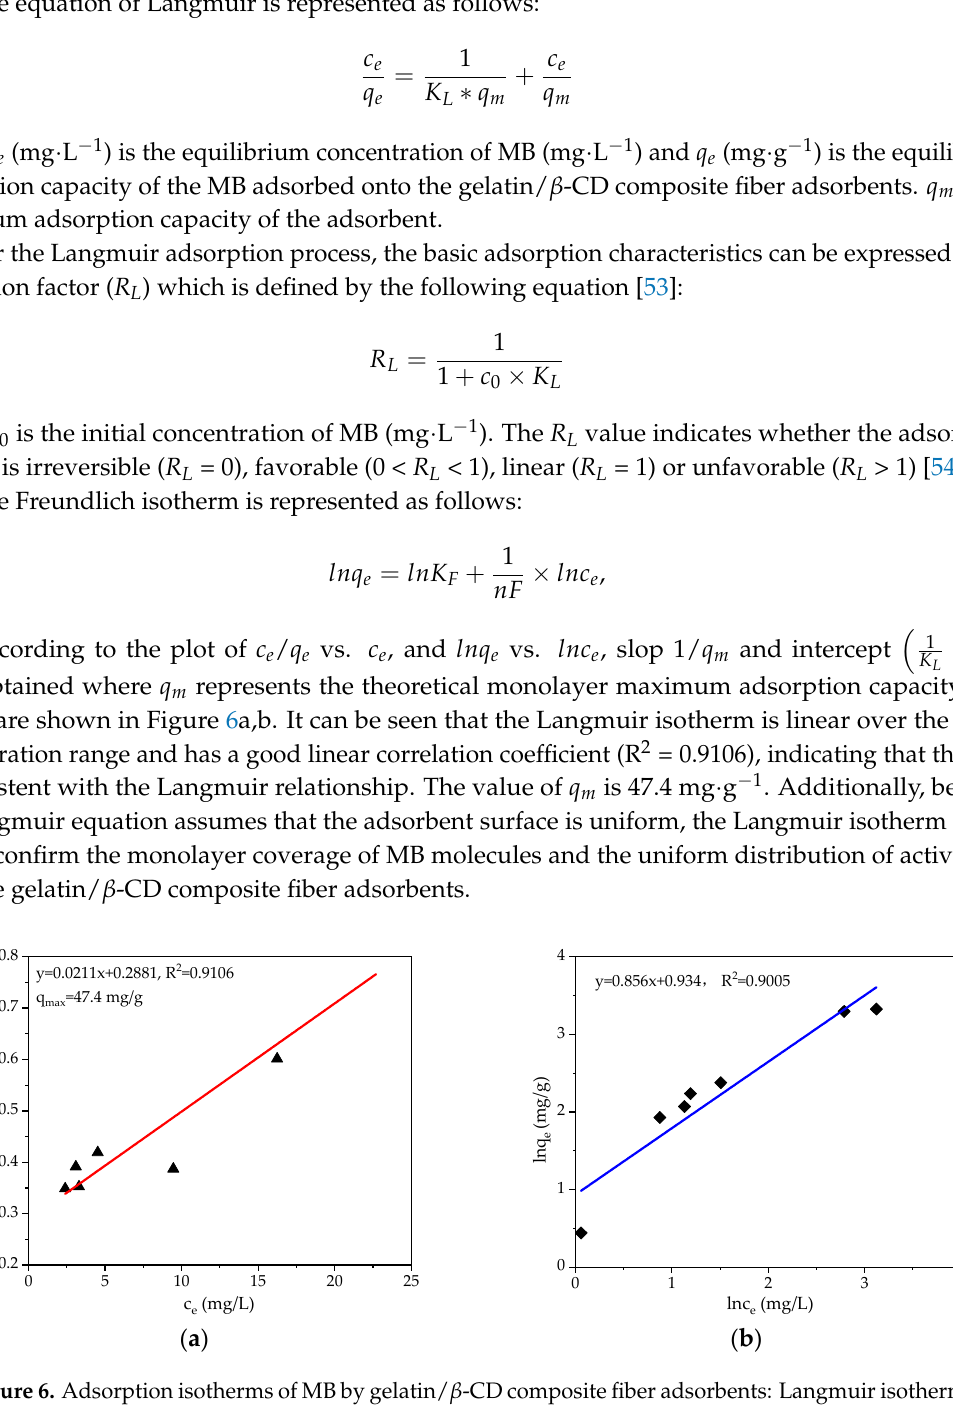
Table 1. Kinetic parameters describing the adsorption of MB onto the gelatin and gelatin/ β -CD composite fiber adsorbents based on the pseudo-first-order and pseudo-second-order kinetic models.